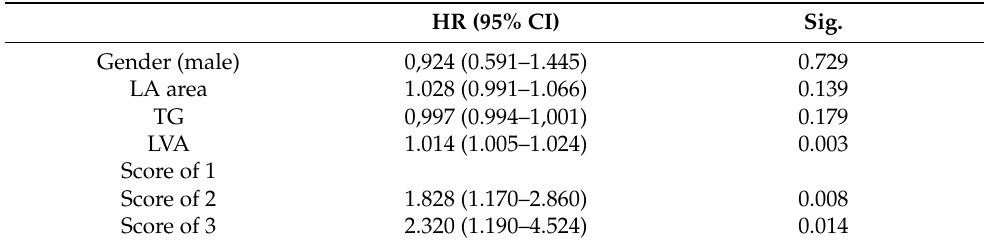
Table 4. Cox regression model with AF recurrence as dependent